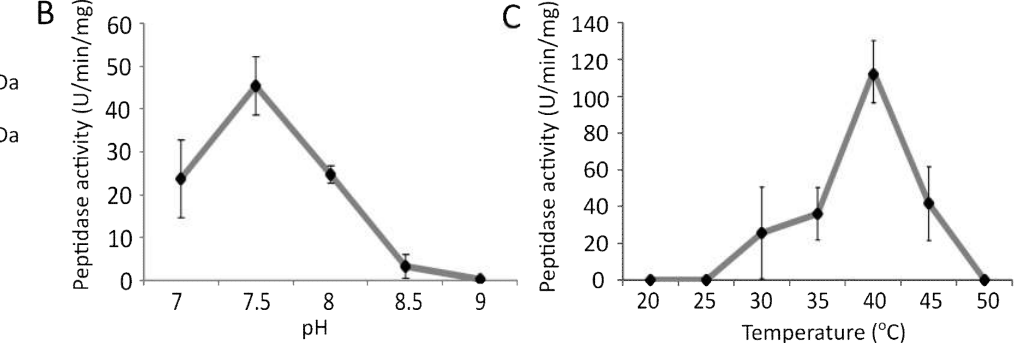
Figure 3. The purified recombinant Svx protein of Pectobacterium atrosepticum (66 kDa) ( A ) and its peptidase activity at different pH values ( B ) and different temperatures ( C ). The pH optimum for the enzymatic activity was determined in 100 mM Tris-HCl buffer at 37 °C. The temperature optimum was determined in 100 mM Tris-HCl buffer pH 7.5.